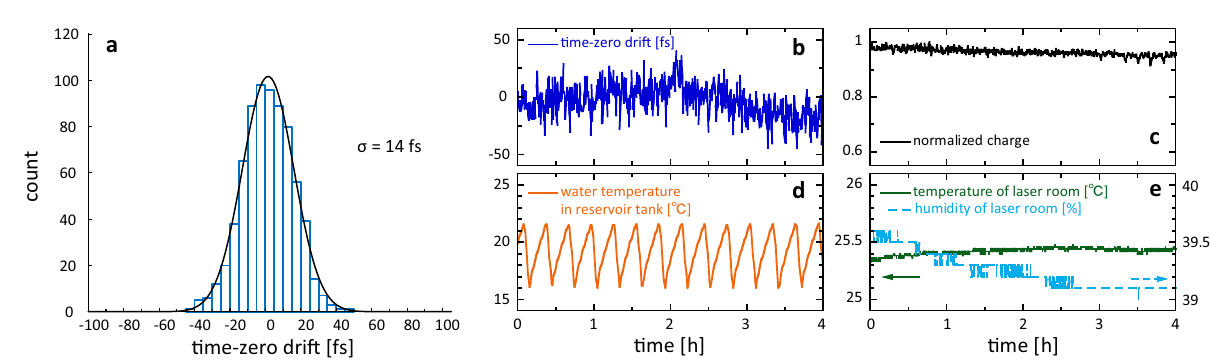
Figure 6. Timing jitter and comparison of the timing drift and environmental parameters. ( a ) Histogram of the time-zero drift with temperature control using the chiller. ( b ) Time-zero drift using the chiller based on the same data as Fig. 5d with the vertical scale expanded. ( c ) Fluctuation in the number of electrons. ( d ) Temperature variation in the reservoir tank of the chiller used to cool the electric stage. ( e ) Temperature and humidity variation of the room containing the laser power of 16.7 fs/pixel. The red lines in Fig. 5c show the results when the system was not subjected to temperature control, revealing a large timing drift in one direction. Owing to this excessive drift, we moved the delay stage every hour to correct the position. All the experimental equipment was installed inside a vacuum chamber. The large drift was attributable to the heat generated by the motor-driven stages and the quadrupole magnets, which was estimated to be several watts. This heat was removed by introducing cooled water into the vacuum chamber, which dramatically suppressed the large drift, as shown in Fig. 5d. The resulting RMS timing jitter was extremely small at only 14 fs (Fig. 6a), which to our knowledge is the lowest value reported to date. The RMS ( 38 fs ) 2 ( 14 fs ) 2 40 fs , demonstrating that this system exhibited extremely high time resolution was then + = temporal resolution. Figure 6c shows the fluctuation of the number of electrons with respect to time. The RMS (cid:31) fluctuation in the number of electrons was 1.3% and it remained stable over a long period. The timing jitter of 14 fs originated from two sources. The first was the resolution of the imaging system composed of the electron lens and fluorescent screen, which can be observed as the short-duration fluctuations in the present time-zero drift measurement (Fig. 6b). The time resolution could be improved by increasing the magnification factors of